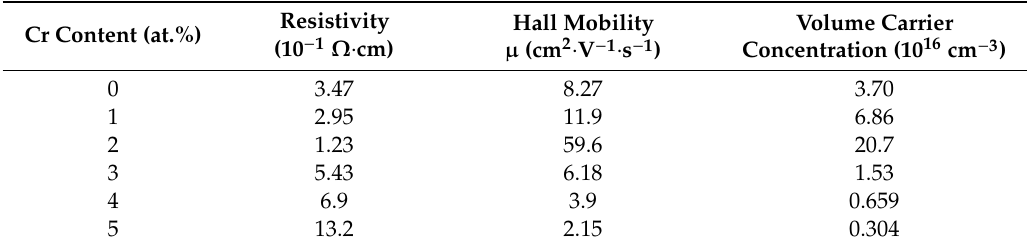
Table 2. Electrical properties of pure and Cr-doped PbS thin films. Cr Content